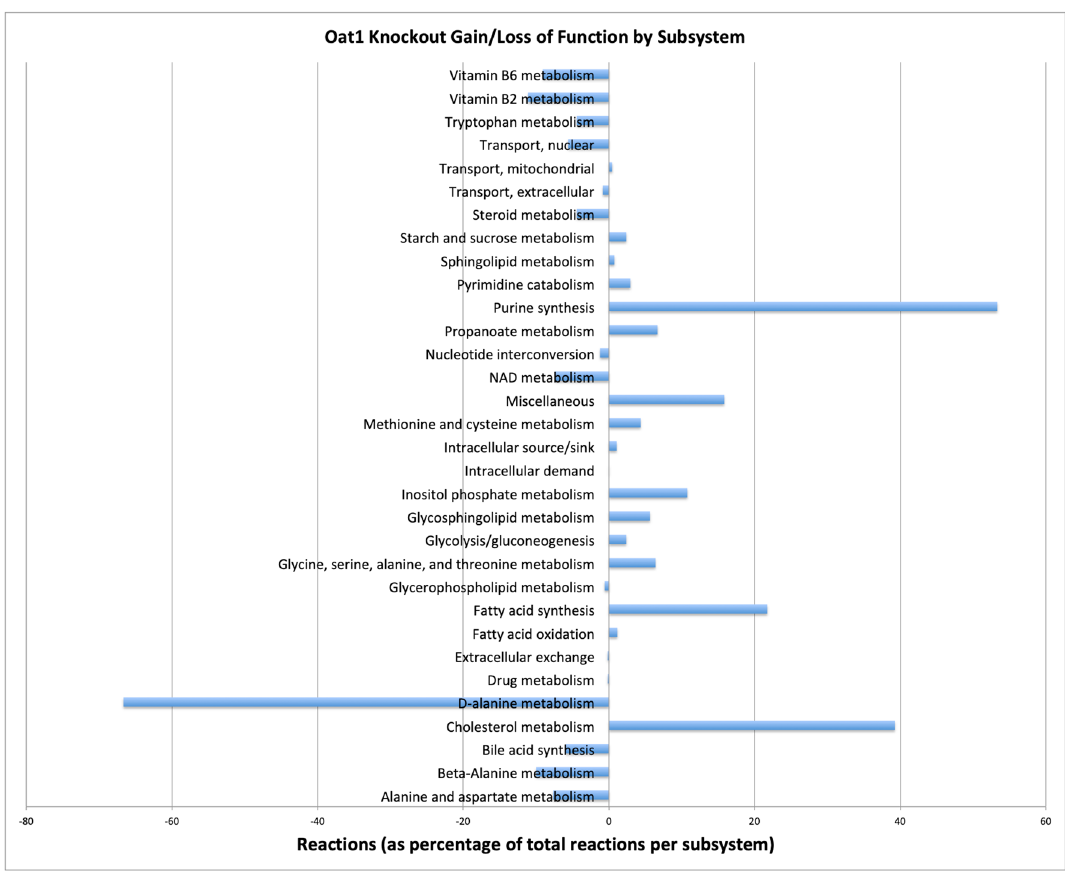
Figure 4. Changes in mutually exclusive reactions in the WT versus OAT1 KO models according to metabolic sub-systems shown as a percentage of the total number of reactions in each Recon3D sub-system. The changes in sub-systems are not uni-directional; some sub-systems increase and others decrease. Notably, in the Oat1KO model there is an increase in purine metabolism, cholesterol metabolism, and fatty acid synthesis, while alanine and aspartate metabolism and Vitamin B metabolism sub-systems are noted to